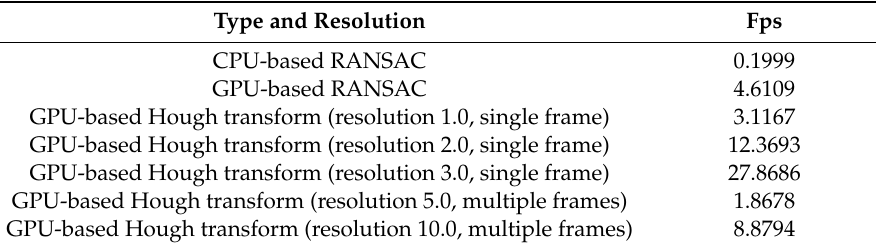
Table 1. Plane detecting the fps